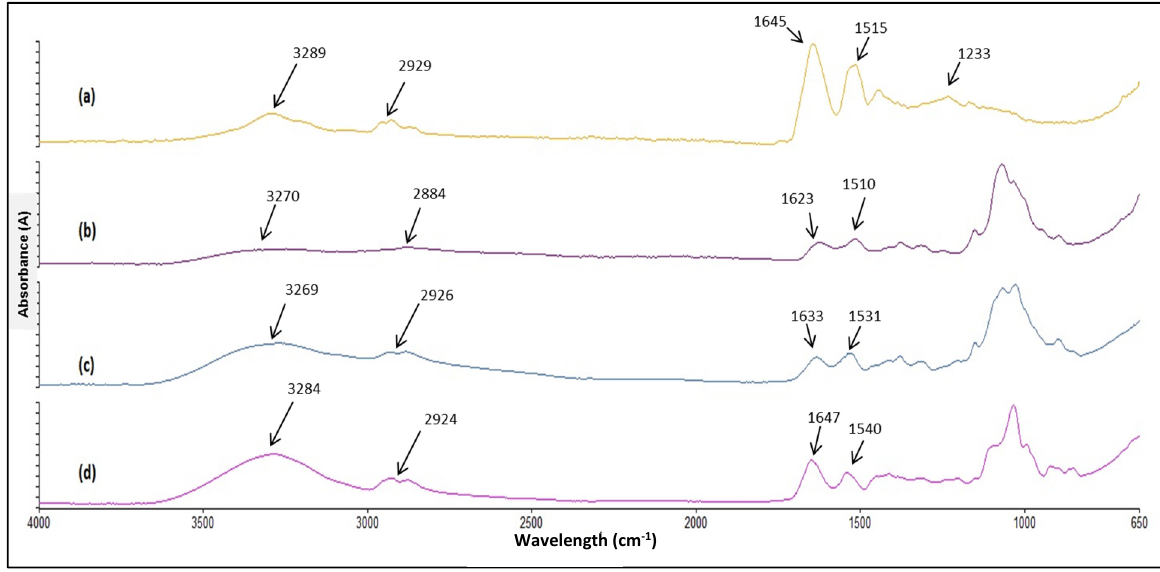
Figure 3. FTIR spectra of ( a ) zein, ( b ) CL113, ( c ) LKP NP and ( d ) LKP CZ NP.